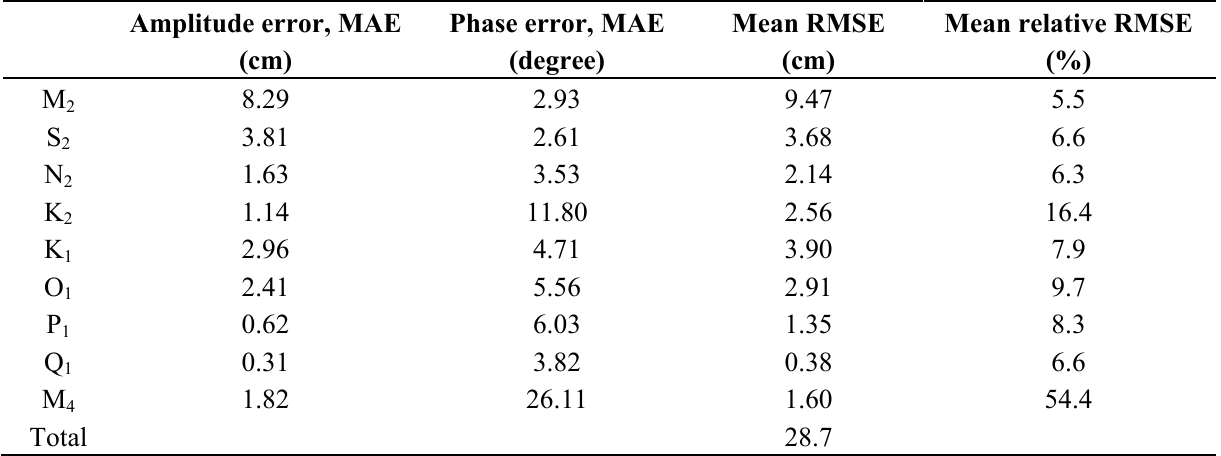
Table 1. Model-observation comparison: error measurements of nine tidal constituents, averaged over 43 tidal stations. MAE, mean absolute error; RMSE, root mean square